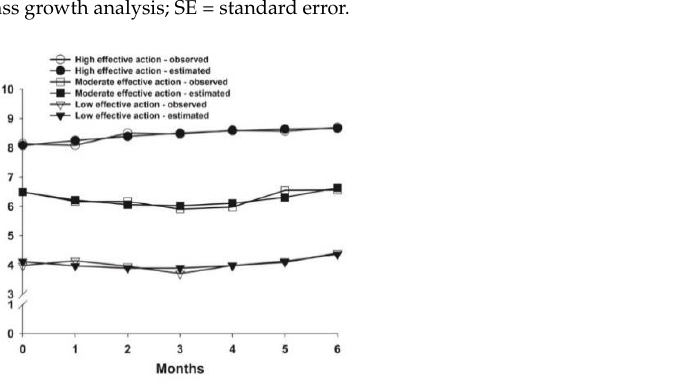
Figure 2. Observed and estimated effective action latent classes from prior to through to 6 months after breast cancer surgery.